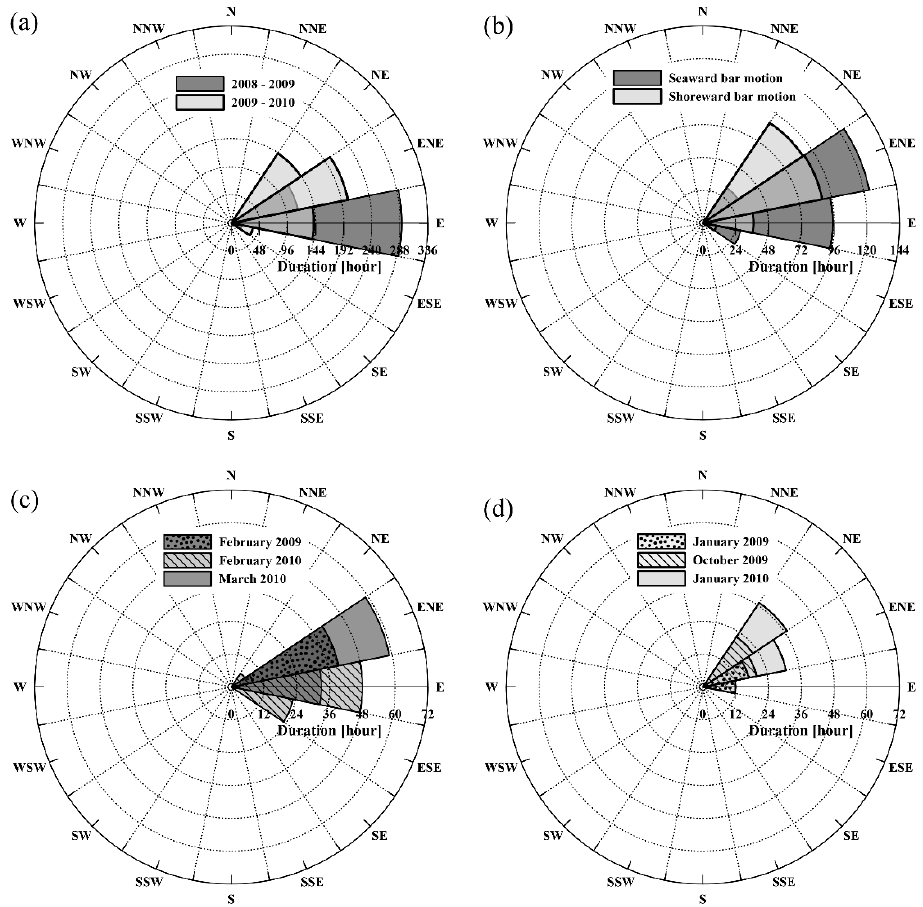
Figure 6. Rose charts of mean direction of wave propagation for: ( a ) storm seasons; ( b ) storm groups SG1&SG2; ( c ) strongest storms moving the outer bar seaward; ( d ) strongest storms moving the outer bar shoreward.